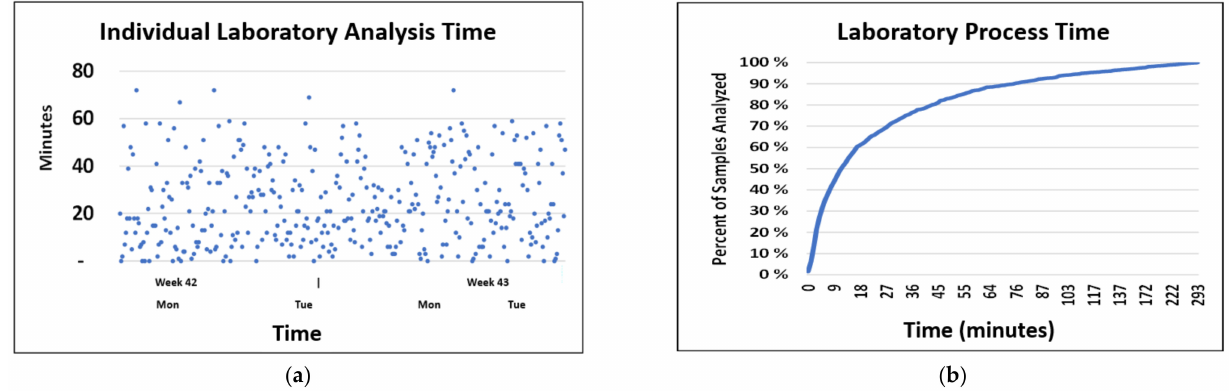
Figure 11. ( a ) Individual times of emergency analyses; ( b ) Accumulated times of emergency laboratory analyses.